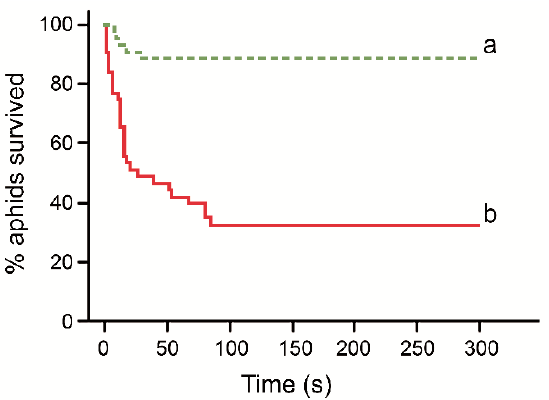
Figure 2. The percentage of experimental Chaitophorus populeti aphids—contaminated with Beauveria bassiana (red solid line) or non-contaminated control aphids (green dotted line)—non-removed by aphid milkers of Lasius fuliginosus (‘survived’) as a function of time. Different letters at the end of the curves indicate significantly different removal in pair-wise comparisons using Kaplan–Meier survival analysis (Gehan’s Wilcoxon = − 5.06, p < 0.0001).